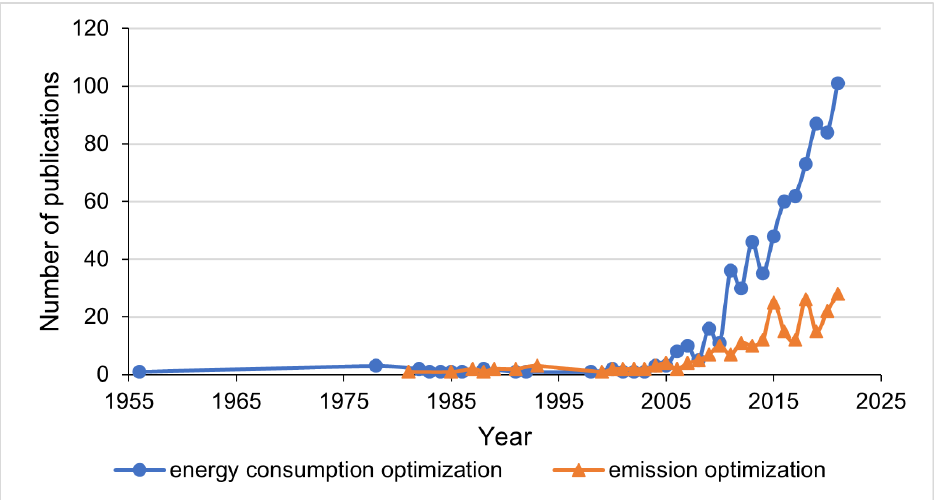
Figure 2. Evolution of Scopus-indexed articles for energy consumption and emission optimiza- tion